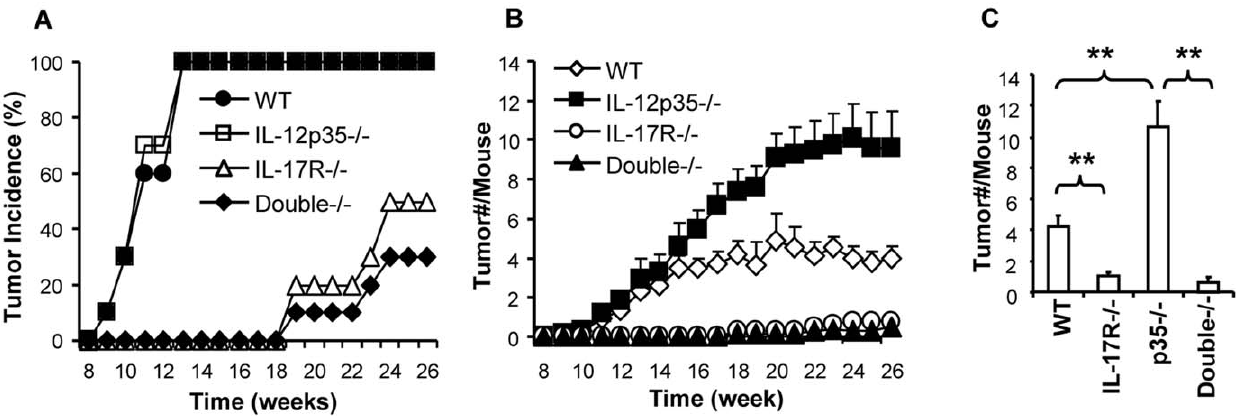
Figure 1. IL-17 receptor deficient mice are resistant to DMBA/TPA induced carcinogenesis. Mice were treated once with DMBA and then with TPA twice a week, as described in the Materials and Methods. Tumor growth was observed every week. A). Tumor incidence. B). Tumor multiplicity. C). The number of tumors was analyzed statistically at the end of experiments (26 weeks). The bar graph shows the mean number of tumors per mouse + / 2 SEM, n =10, ** p , 0.01. Data are representative of two independent